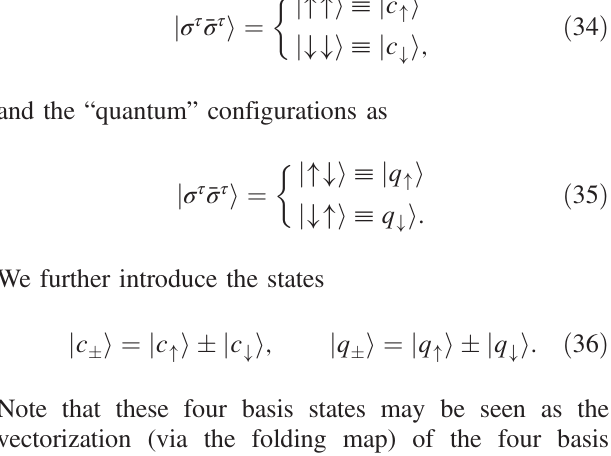
FIG. 5. Growth of the maximal (half-time) bipartite temporal entanglement entropy S ð t Þ of the influence matrix viewed as a wave function in the folded space. It is plotted as a function of time, for a small detuning δ J ¼ δϵ ¼ 0 . 06 from the PD point, and h ¼ 0 . 3 . Entropy growth is approximately linear in time but slow enough for the influence matrix with t ≲ 20 to be accurately captured by a MPS with a bond dimensions χ ≲ 256 . Inset: slope of entanglement entropy ∂ S= ∂ t as a function of detuning δ J ¼ δϵ . As the system approaches the PD point, this slope goes to zero. We note that the slope remains small in a broad range of detuning, enabling efficient MPS